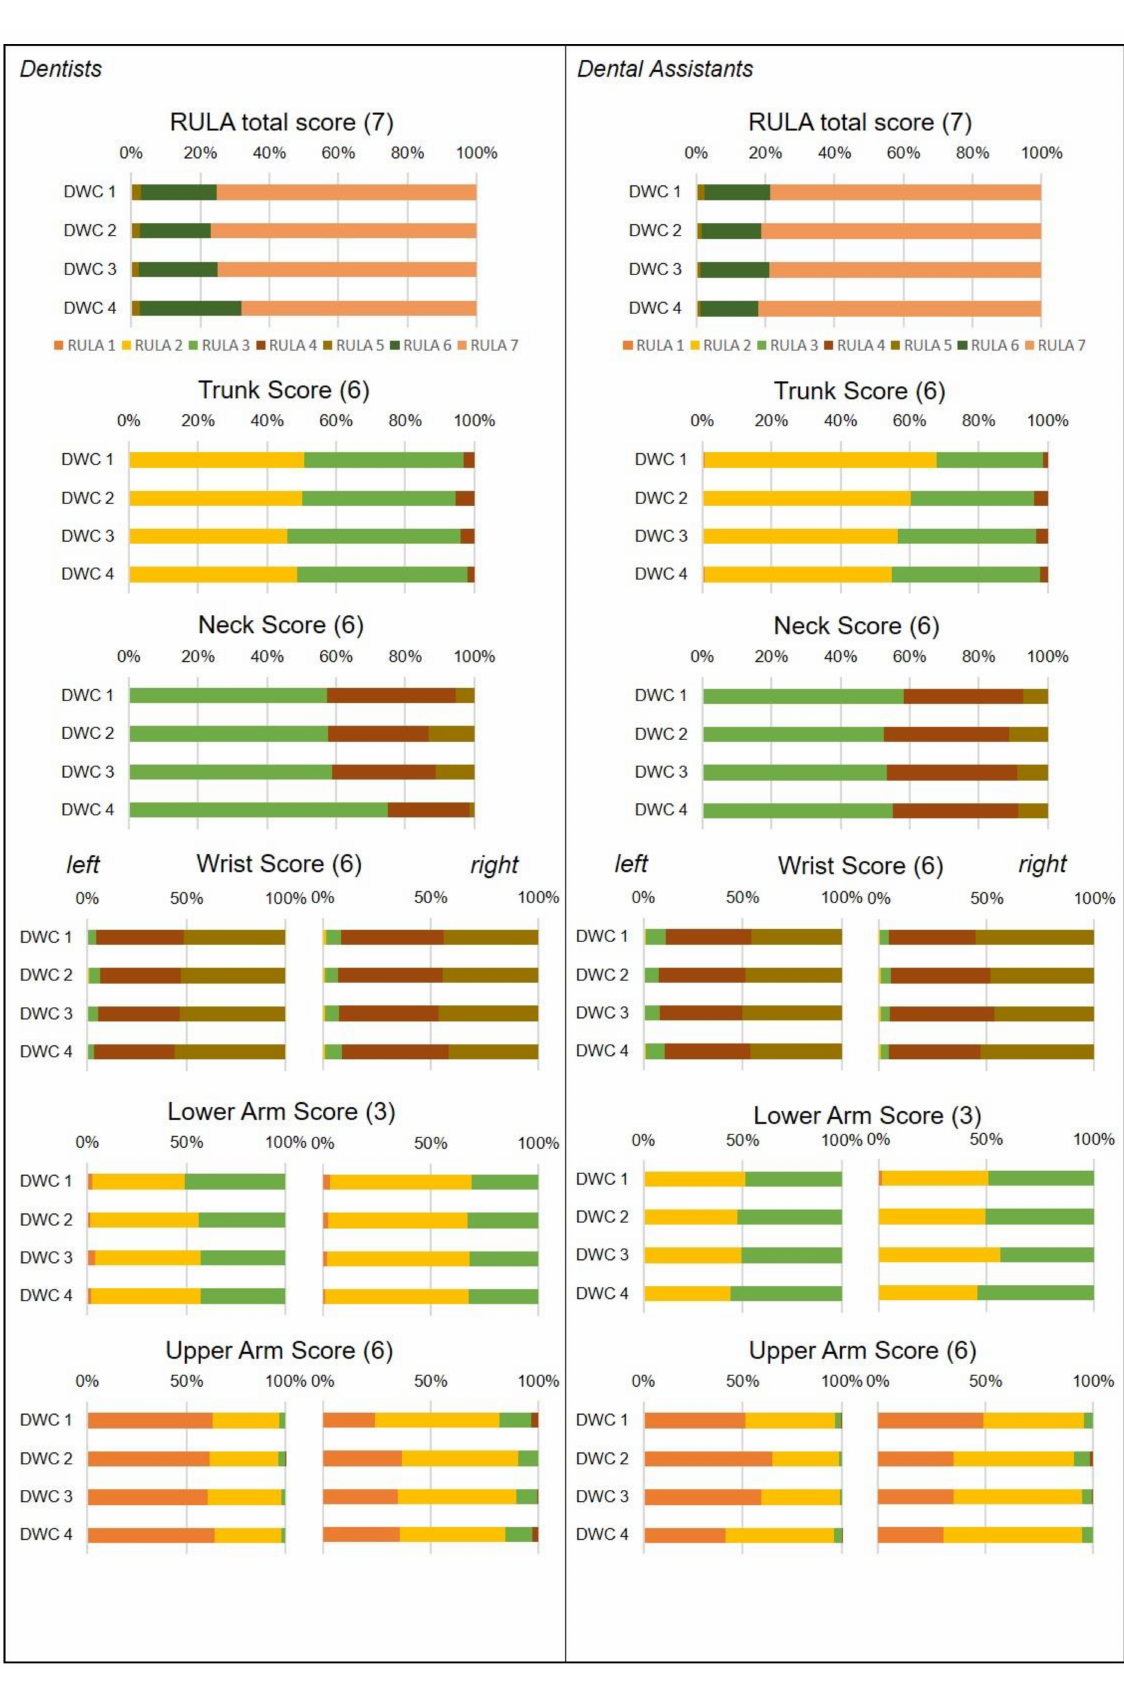
Figure 4. Relative average risk score over the time of the different RULA scores for all four DWCs. DWC—dental workplace concept. The maximum possible score of each body region is specified in